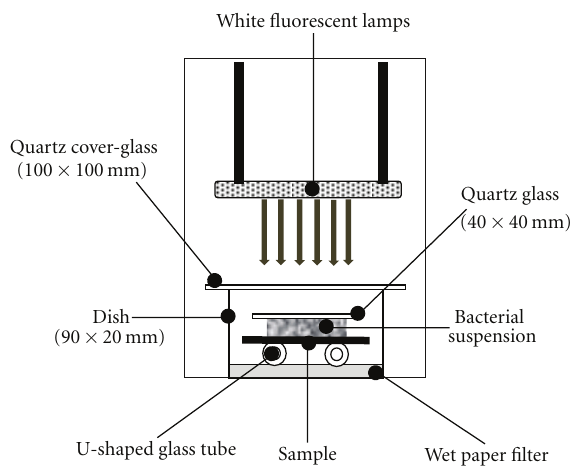
Figure 1: Schematic illustration of assessment method for investi- gating the bactericidal e ff ect of PTFE hydrophobic composite films with and without the addition of N-doped TiO 2 .